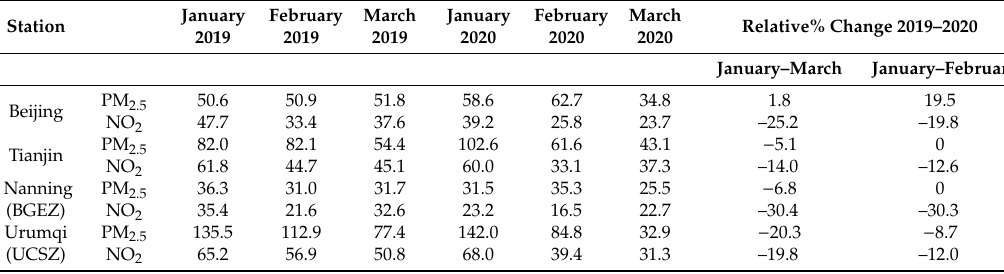
Table 2. Average daily fine particulate (PM 2.5 ) (µg/m 3 ) and NO 2 data (µg/m 3 ) from street-level air sampling stations in Beijing, Tianjin, Nanning, and Urumqi. Source: China National Environmental Monitoring Center (CNEMC). NO 2 data are collected with a Model 42i Chemiluminescence Analyzer following the United States Environmental Protection Agency (US EPA) guidelines. EU recommended